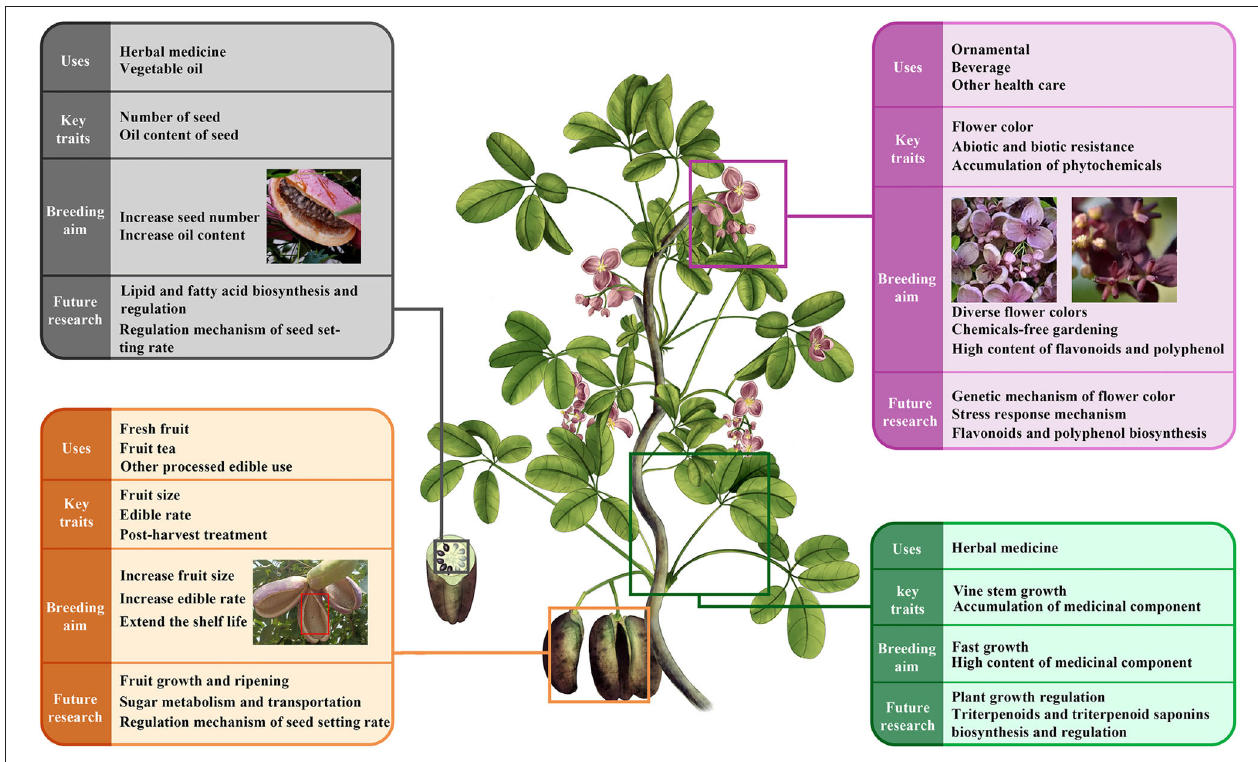
FIGURE 3 | Potential uses, key traits, and breeding aim of Akebia